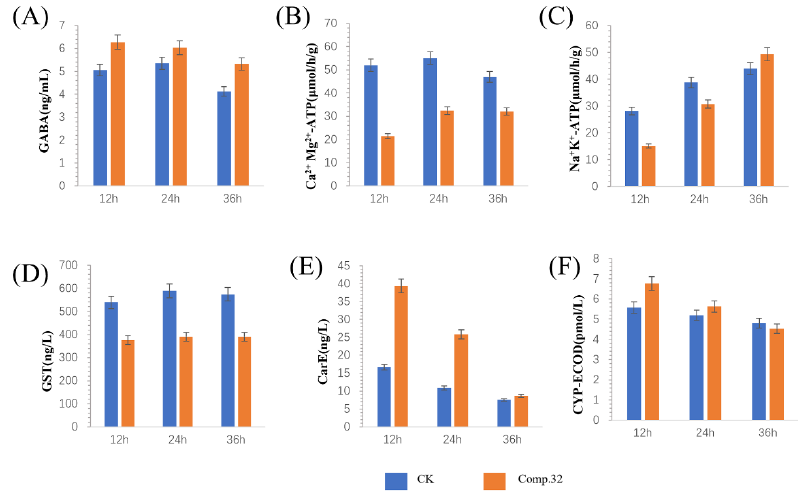
Figure 6. Effect of compound 32 on the enzyme activities of GABA ( A ), Ca 2+ Mg 2+ -ATP ( B ), Na + K + -ATP ( C ), GST ( D ), CarE ( E ), and CYP-ECOD ( F ) of the diamondback moth. Vertical bars indicate mean ± SD (n = 3).